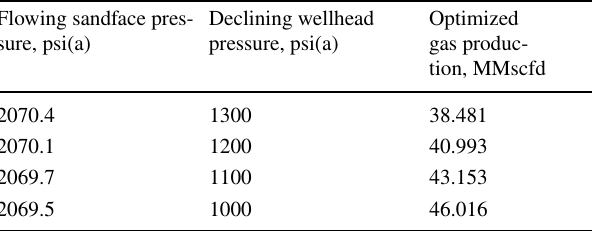
Fig. 6 The liquid lift ratio in the optimum condition of the HBJ-06, where C 1 , C 2 , C 3 and C 4 curves represent the minimum gas rate to lift condensate and W 1 , W 2 , W 3 and W 4 curves, minimum gas rate to lift water in different wellhead pressure condition. The different curves